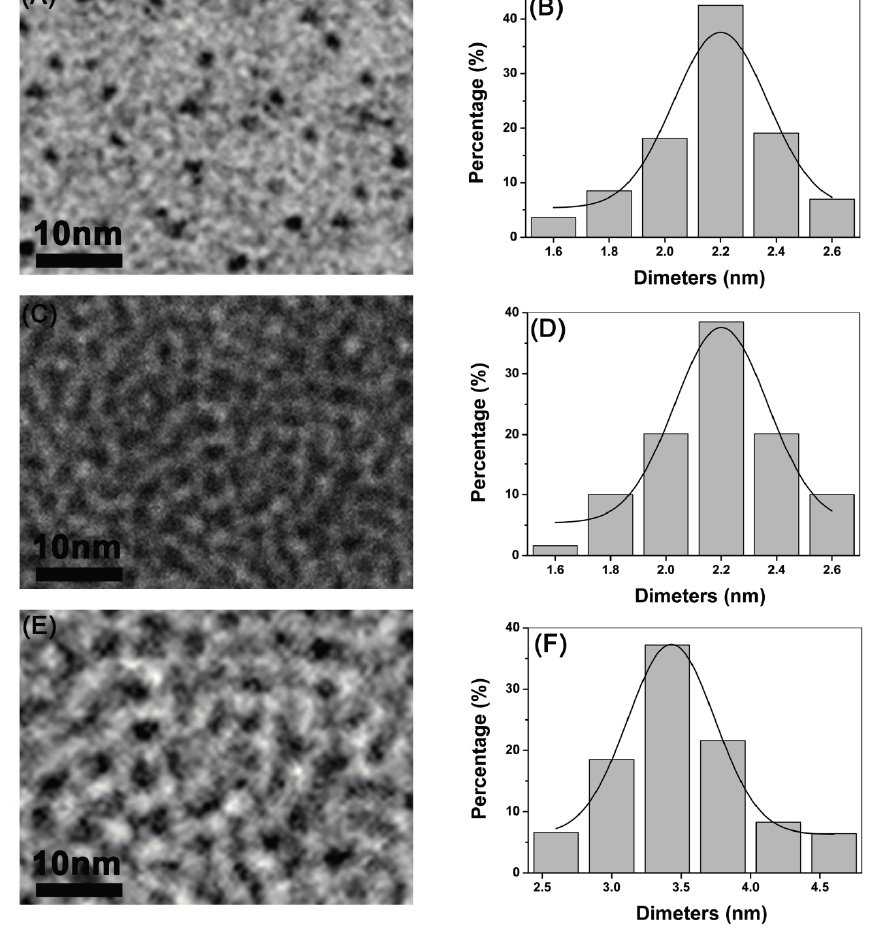
Figure 1. Characterization of QDs. ( A ), ( C ) and ( E ) represents the TEM characterization of 2.2 nm CdSe QDs, 2.2 nm CdTe QDs and 3.5 nm CdTe QDs respectively; ( B ), ( D ) and ( F ) depict size distribution by DLS characterization of 2.2 nm CdSe QDs, 2.2 nm CdTe QDs and 3.5 nm CdTe QDs,